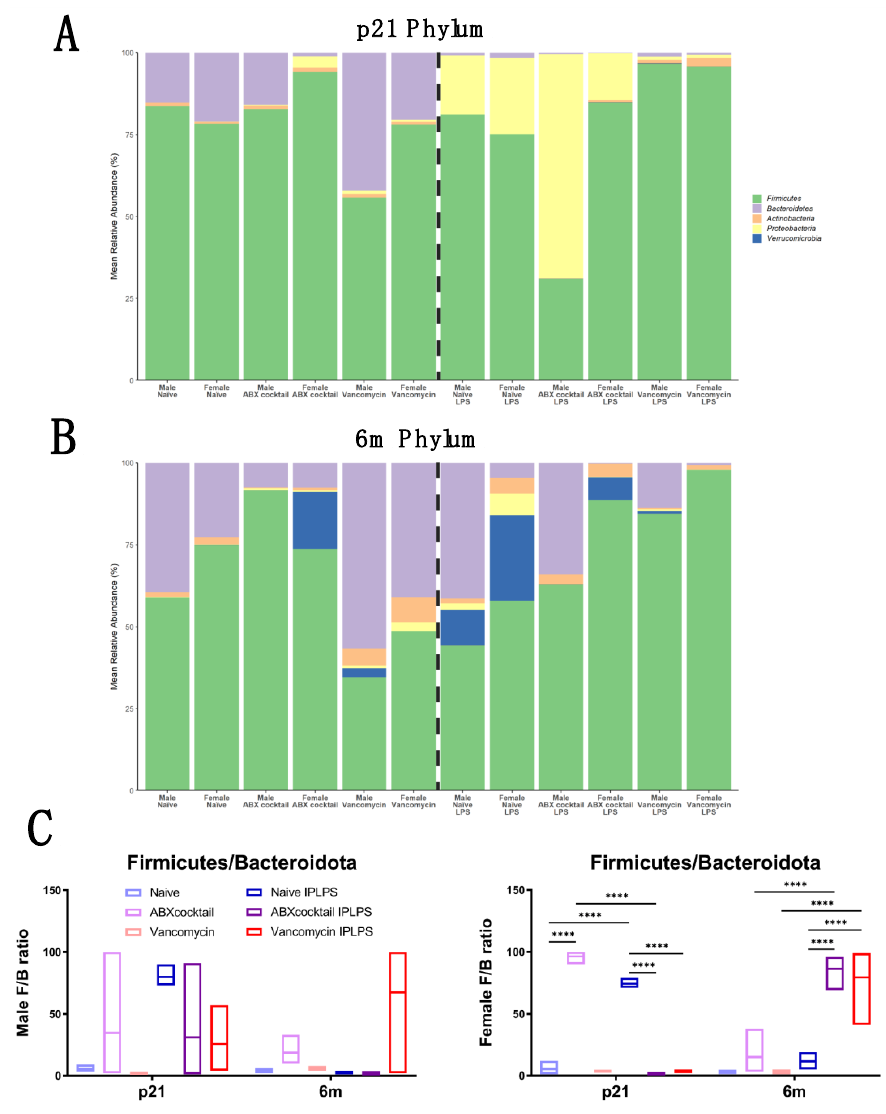
Figure 2. Prenatal ABX administration alters offspring gut microbiota taxonomy. ( A , B ) Relative abundances of sequences classified to phylum at p21 and 6m, respectively, with Firmicutes being the most abundant in both. Only phyla with a significant number of reads are shown. ( C ) Firmicute s/ Bacteroidetes ratios where bars represent the group mean. Each color represents a unique prenatal basal exposure combined with or without LPS stimulation: naive = light blue, vancomycin = light red, ABX-cocktail = light purple, naive LPS = blue, vancomycin LPS = red, and ABX-cocktail LPS = purple. Naive, ABX-cocktail, and vancomycin samples were run in parallel, the number of mice in each group were male n = 3 and female n = 3. The levels of significance ( p -values) determined by two-way ANOVA test followed by Tukey post-correction test for multiple comparisons. The bar values represent means + SEM, **** p ≤